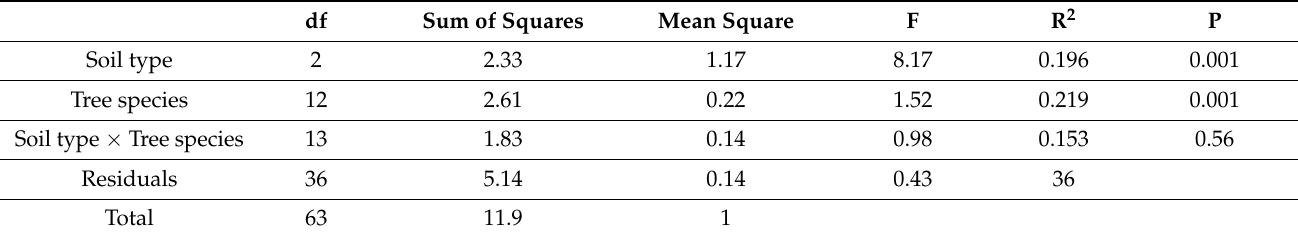
Table 1. Differences in soil metabolome by soil type (forest floor, suspended soil +/ − epiphyte) ( n = 3) and tree species ( n = 13), as tested by PERMANOVA. df Sum of Squares Mean Square